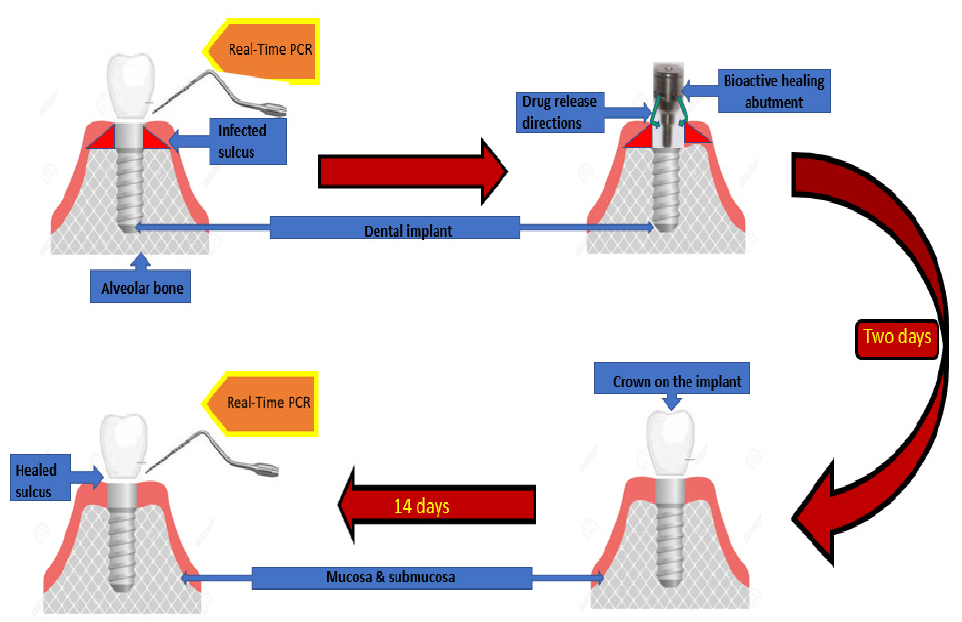
Figure 1. The research study scheme design.